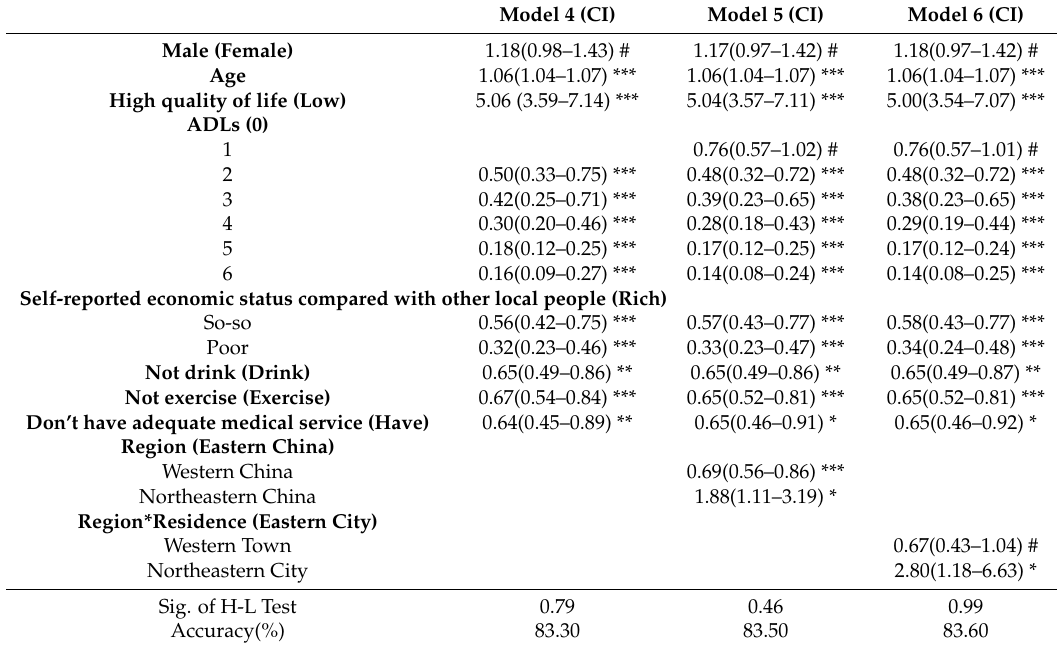
Table 4. Binary logistic regression for odds ratios of self-reported health (Unhealthy as